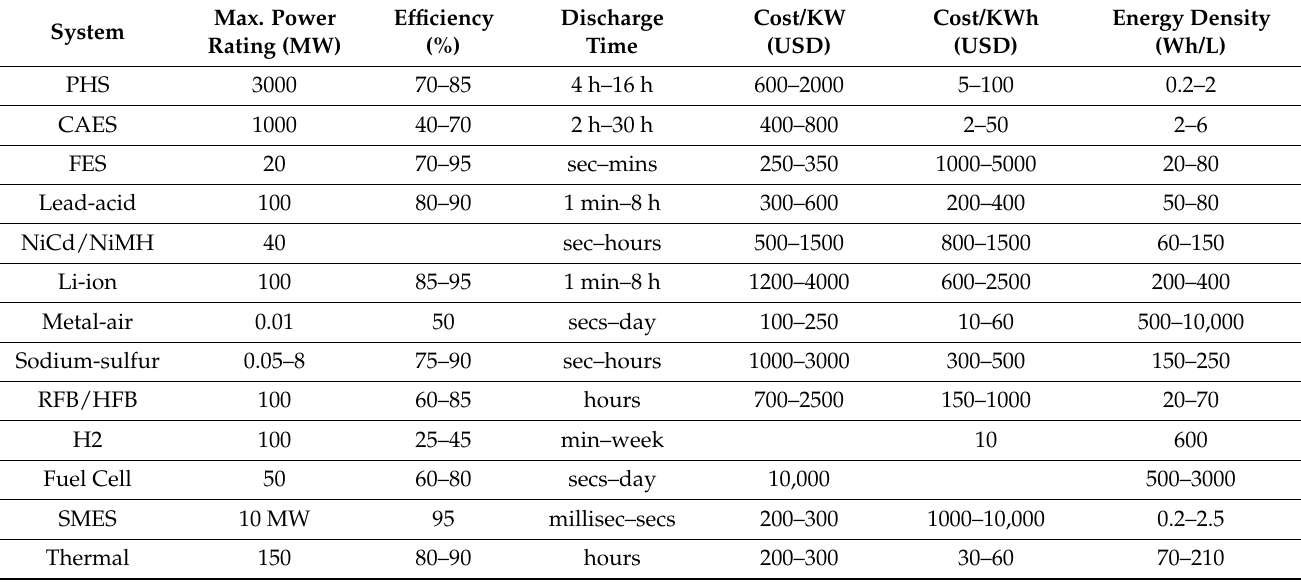
Table 5. Comparison of EES Systems in terms of efficiency, discharge time and cost [126–129].